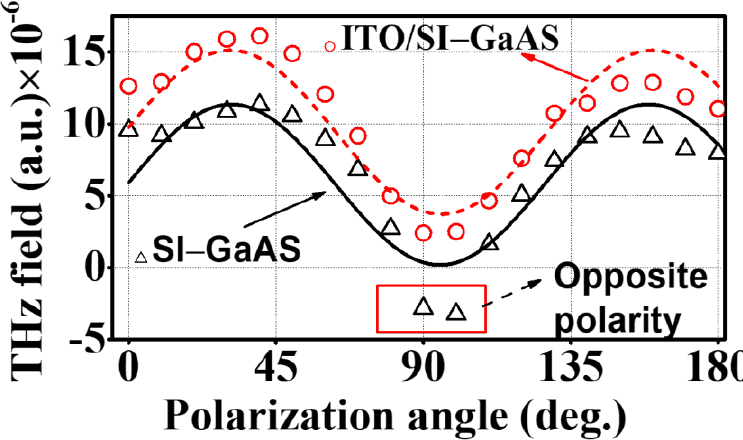
Figure 8. THz electric field dependence on polarization angle at fixed pump intensity and incidence angle .